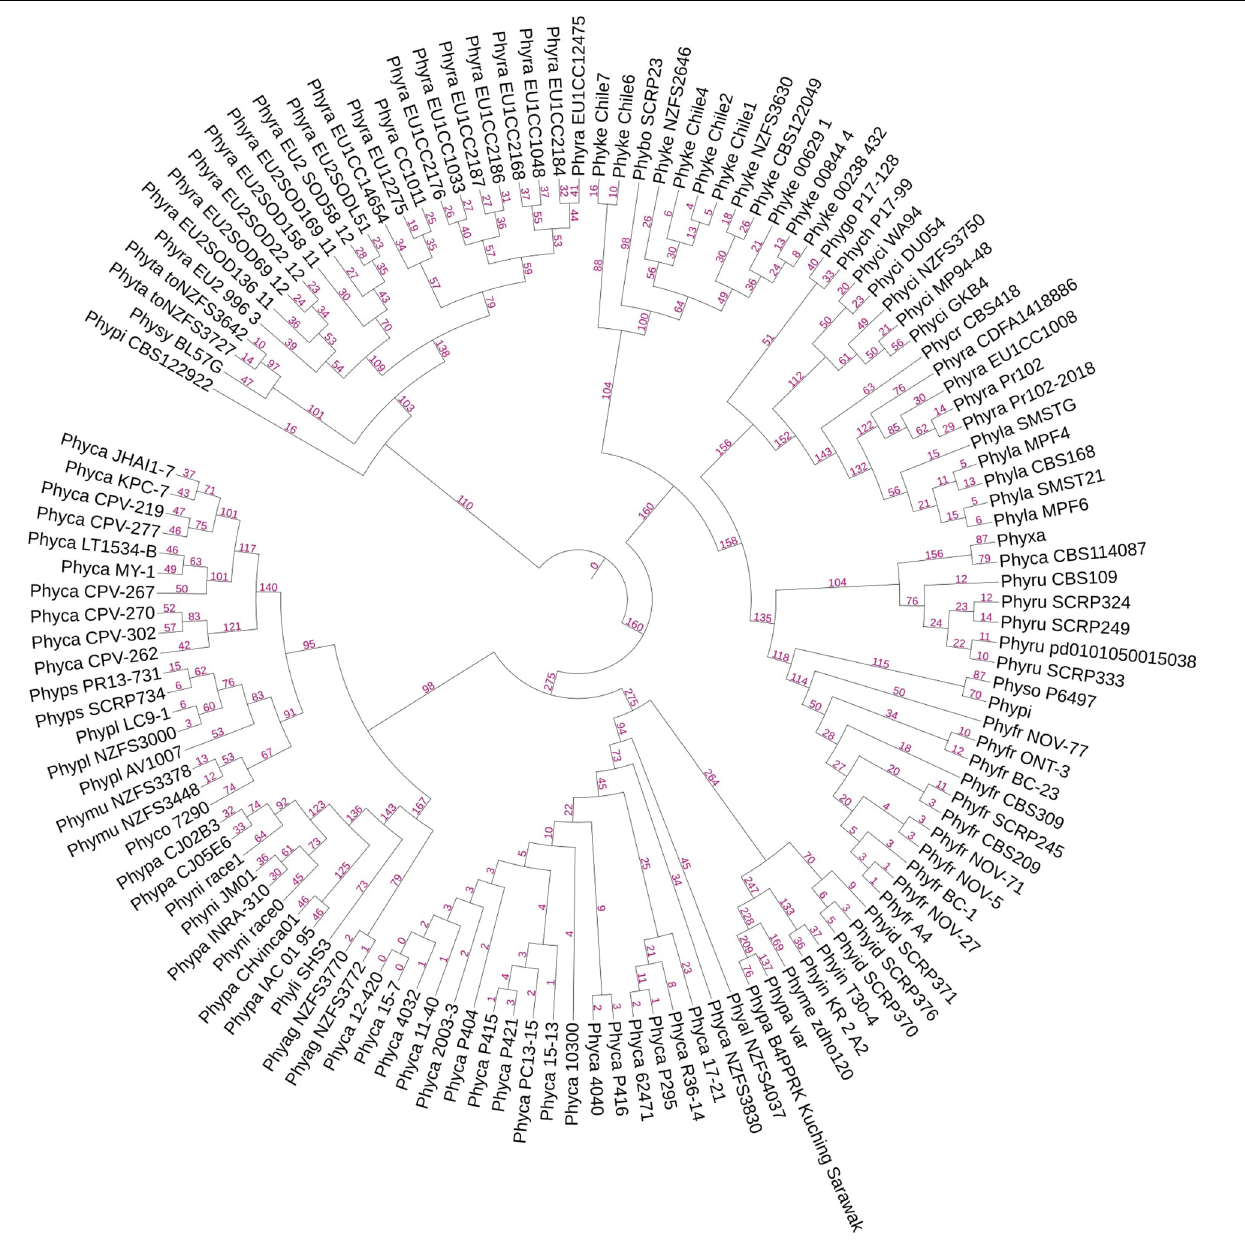
FIGURE 3 | A UPGMA-based rooted species tree showing placement of 128 genomes on the basis of RxLR orthologous clusters. The branching lengths are shown in pink color on the branches of the tree. Species-specific distribution of RxLR effectors was found in most of the cases. There are exceptions where some species have closeness to other species than within themselves. Examples are species P. parasitica , P. nicotianae , and P. kernoviae .